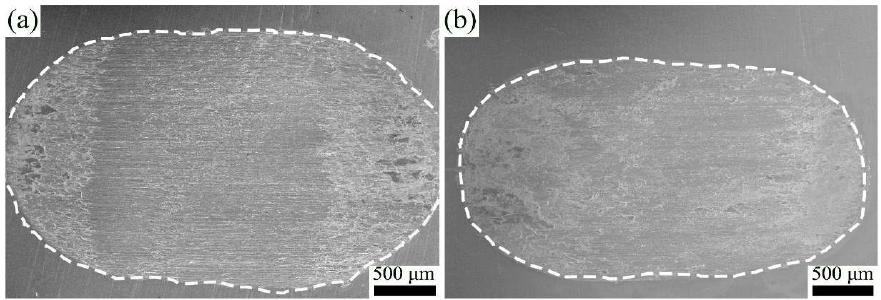
Figure 8. SEM images of worn surface morphologies of ( a ) the substrate (Ti6Al4V) and ( b ) the coating (Al 1.0 ) at room temperature under dry sliding wear test conditions.